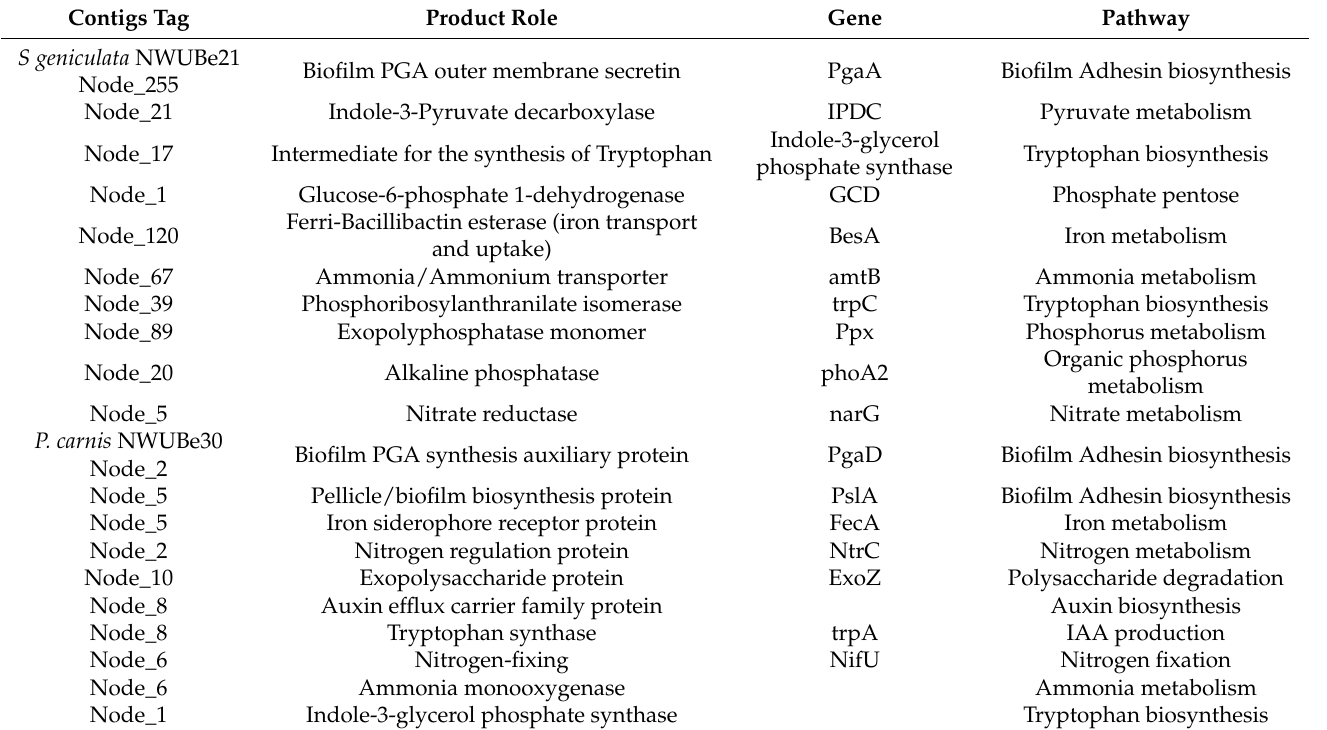
Table 4. Plant growth-stimulating genes in the genome of P. carnis strain NWUBe30 and S. geniculata strain